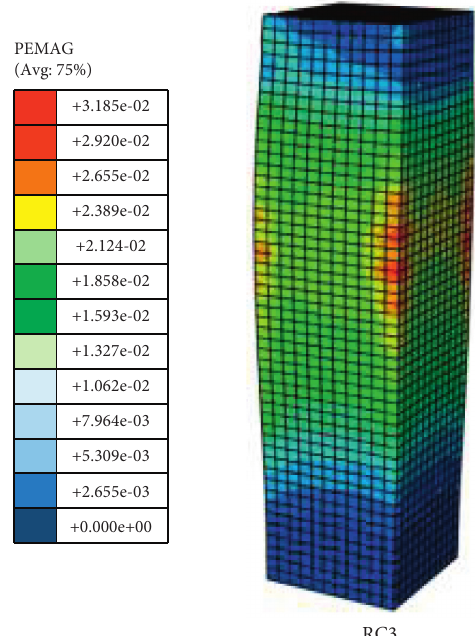
Figure 13: Strain cloud picture of RC3